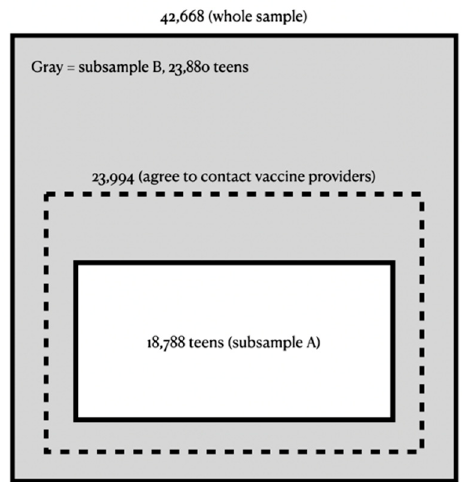
Figure 1. Study samples for the current study: the whole sample (42,668 teens) and the two subsamples, subsample A (18,788 teens) and subsample B (23,880 teens). 2.3. HPV-Unvaccinated Teens.